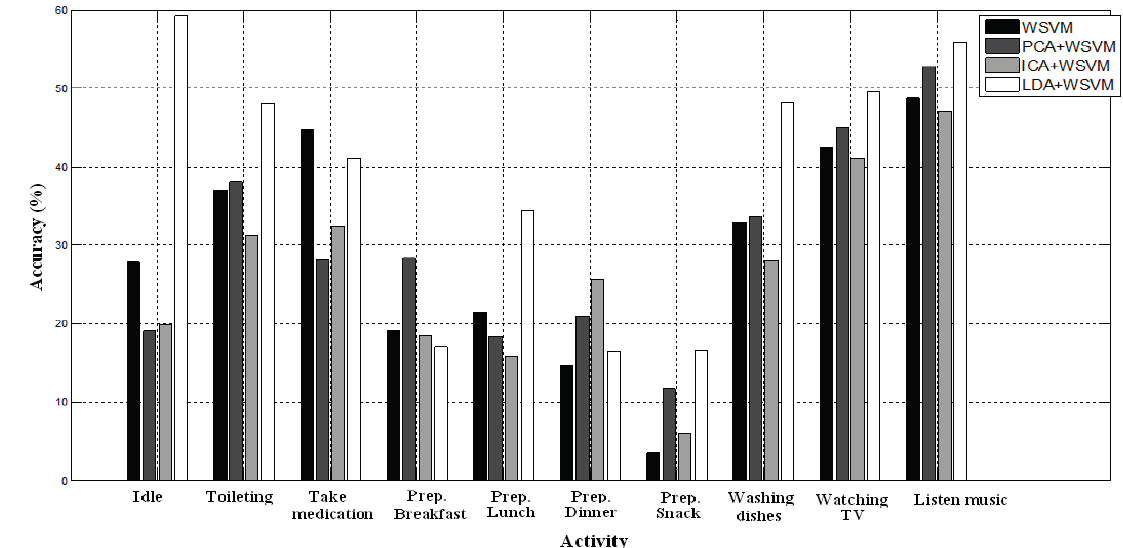
Figure 5. Accuracy for each activity on TAP80F